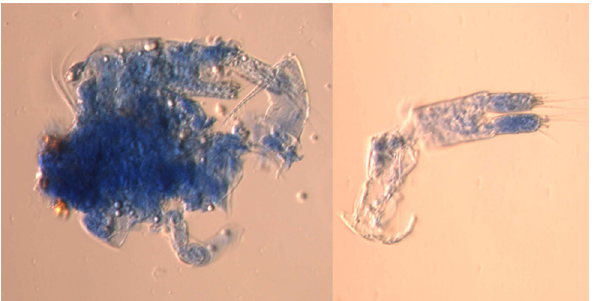
Fig 4. Gut content extracted from Megacyclops gigas showing remains of cyclopoid copepods.